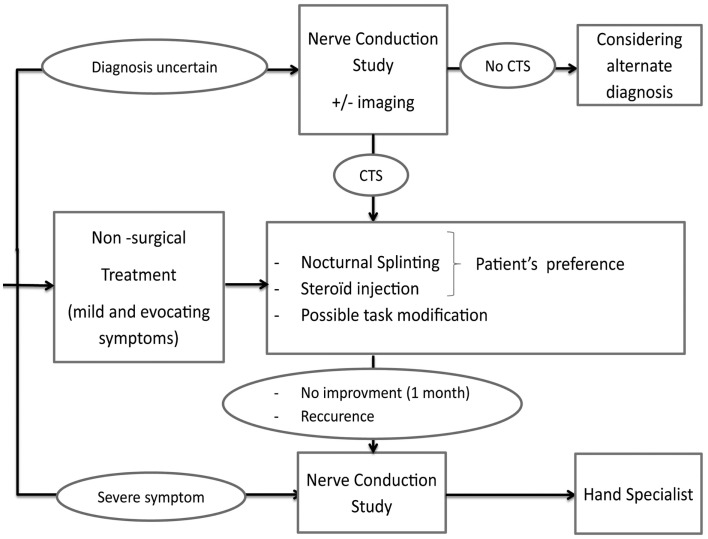
Treatment algorithm.